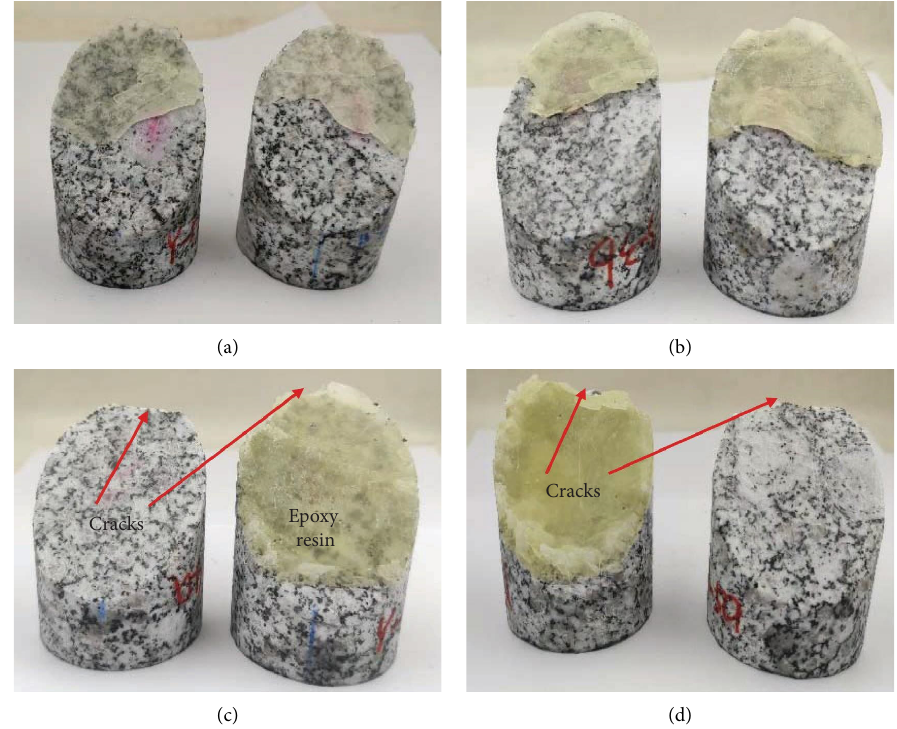
Figure 24: Epoxy resin repaired samples with diferent repair widths (a) 1mm; (b) 3 mm; (c) 5 mm; and (d) 7 mm after failure at day